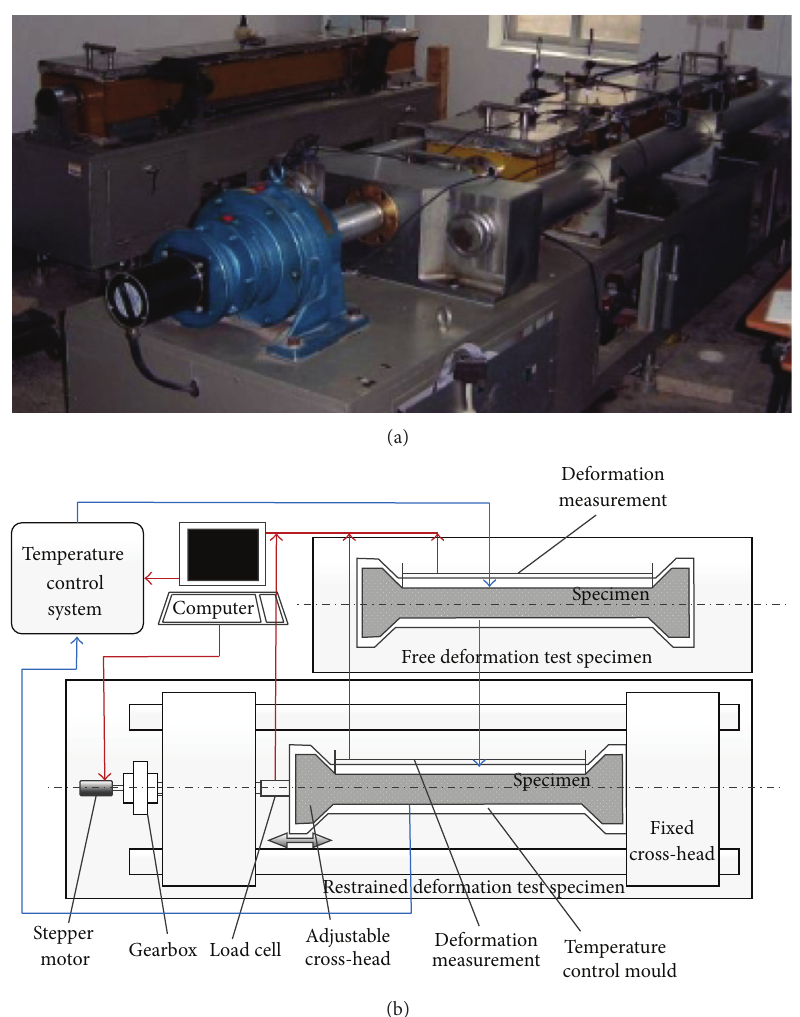
Figure 1: Details of the experimental setup. (a) Photograph of temperature stress testing machine. (b) Schematic diagram for TSTM.